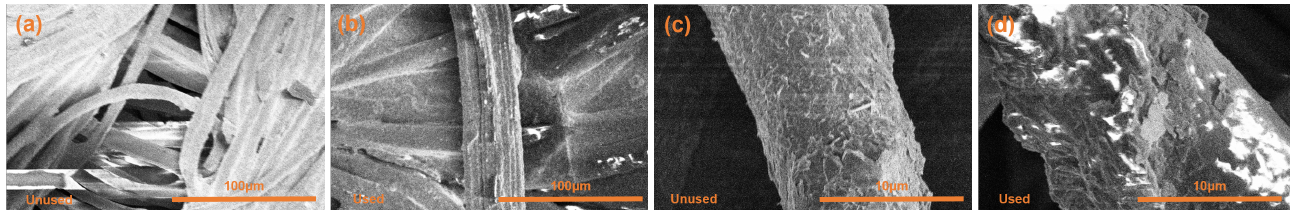
Figure 4. SEM images of graphene strain gauge for: ( a , c ) unused device, ( b , d ) used